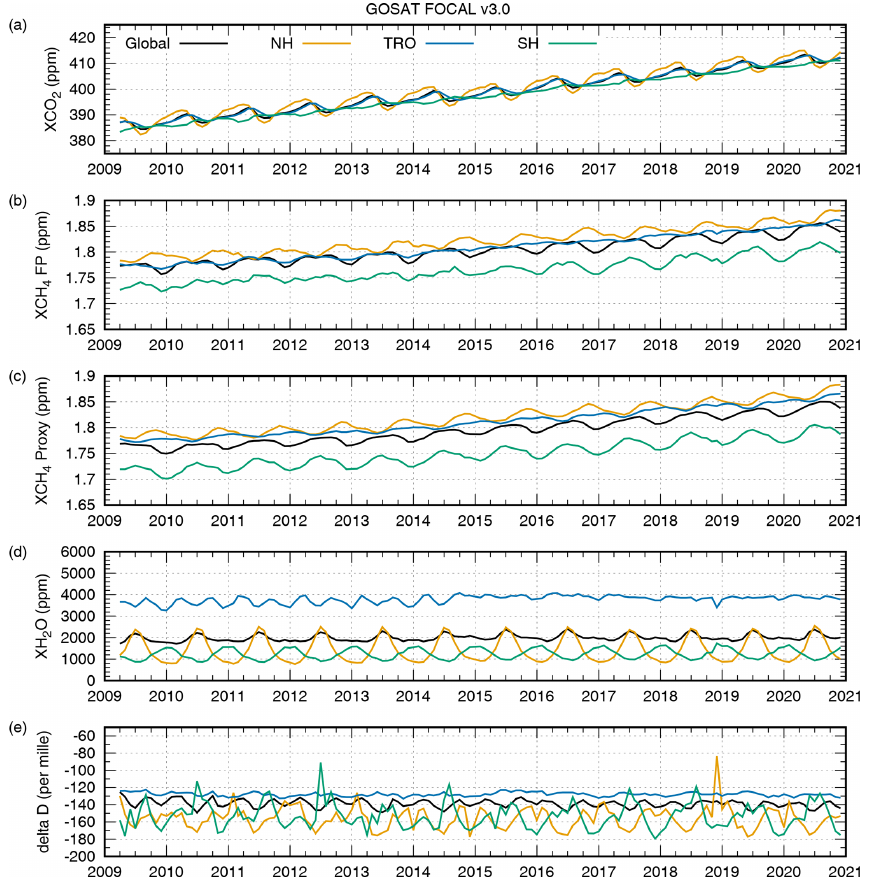
Figure 9. GOSAT time series. NH = Northern Hemisphere ( > 25 ◦ N). TRO = tropics (25 ◦ S–25 ◦ N). SH = Southern Hemisphere ( < 25 ◦ S). (a) XCO 2 ; (b) XCH 4 full-physics product; (c) XCH 4 proxy product; (d) XH 2 O; (e) δ